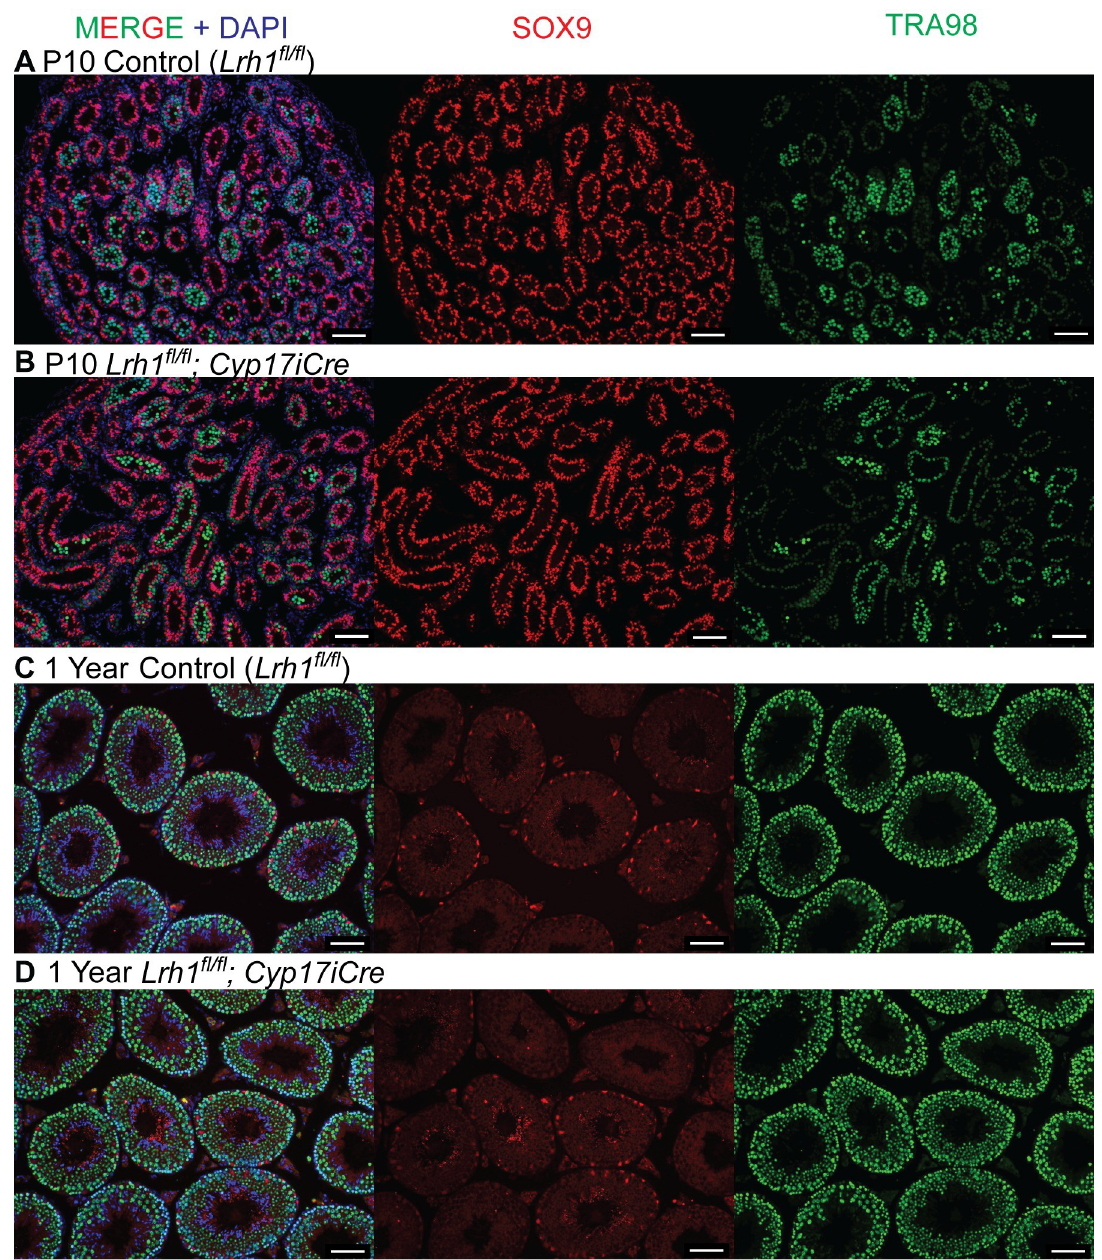
Fig 4. Lrh1 is dispensable in Leydig cells. IF of control and Leydig cell conditional Lrh1 homozygous mutant testes at P10 (A,B) and one year (C,D), stained for Sertoli cell marker SOX9 (red), germ cell marker TRA98 (green), and DNA marker DAPI (blue). Scale bars: 100